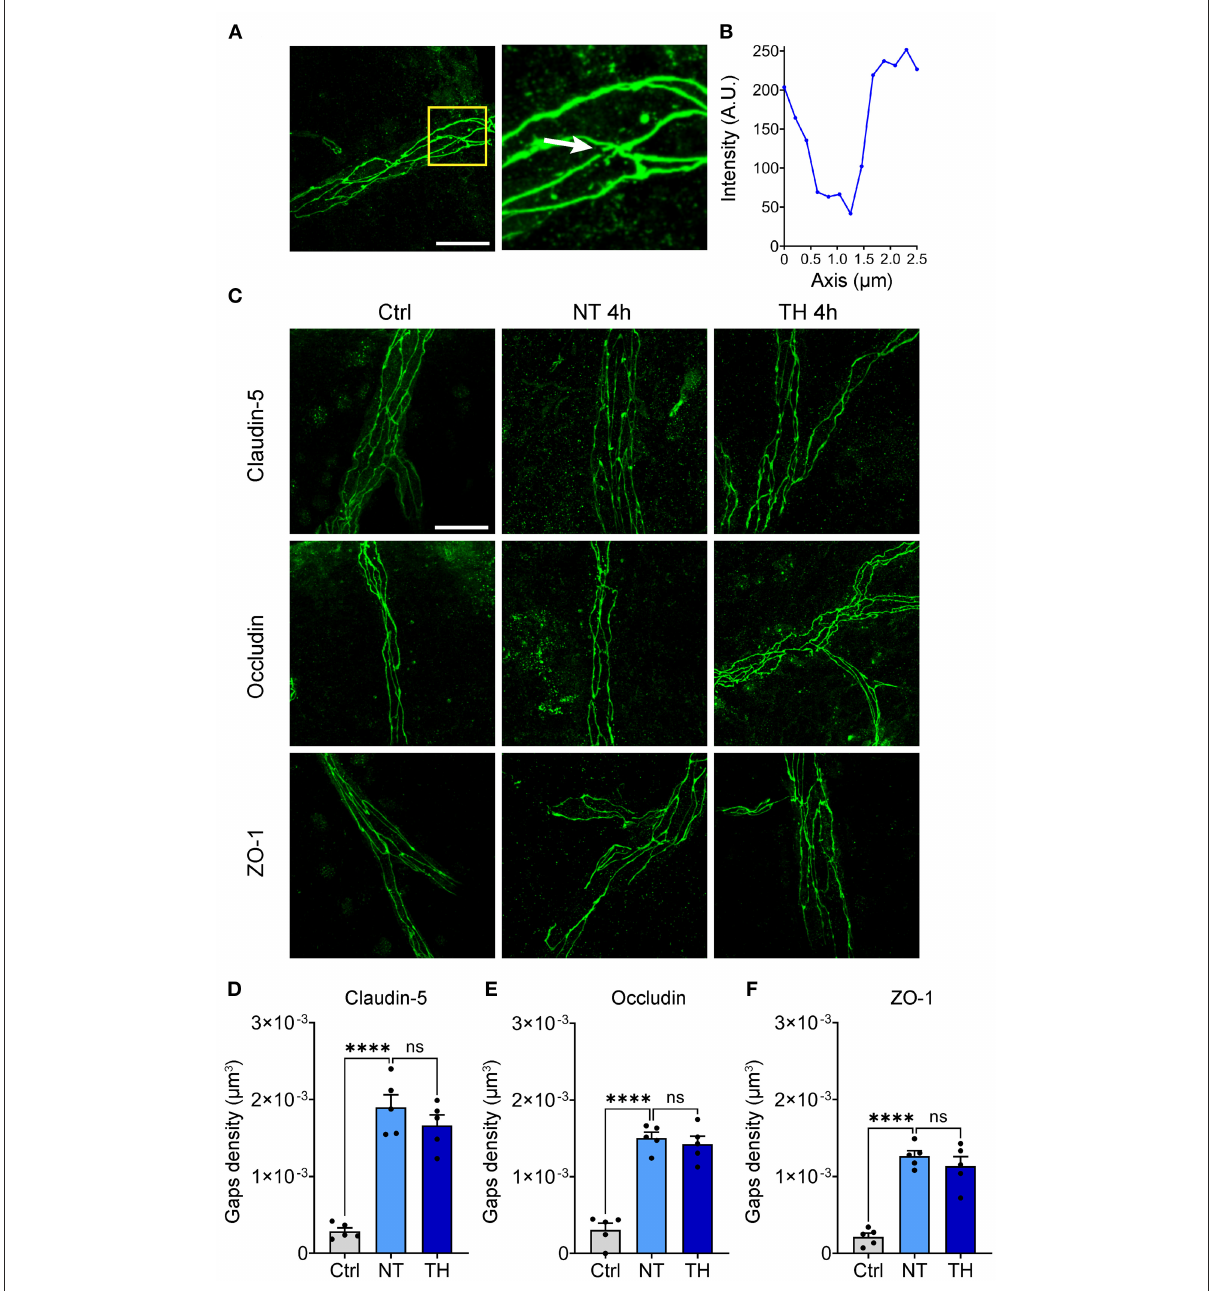
FIGURE4 The effect of TH on structural damage to the TJs after SCI. (A) Representative images of the gaps in the TJs (white arrow). Scale bar: 20 µ m. (B) Fluorescence intensity decline of the gap in Figure 1A. Fluorescence intensity declines of 70% were identified as a gap. (C) Representative images of immunofluorescence staining of TJs 4h post-SCI. Scale bar: 20 µ m. (D) The density of the gaps that emerged on claudin-5 with TH 4h post-SCI ( n = 5 per group, total 153 vessels, Ctrl & NT: P < 0.0001, NT & TH: P = 0.415). (E) The density of gaps that emerged on occludin with TH 4h post-SCI ( n = 5 per group, total 152 vessels, Ctrl & NT: P < 0.0001, NT & TH: P > 0.99). (F) The density of gaps that emerged on ZO-1 with TH 4h post-SCI ( n = 5 mice per group, total 157 vessels, Ctrl & NT: P < 0.0001, NT & TH: P = 0.609). Data are shown as mean ± SEM; ns, non-significance; **** P < 0.0001; nested, one-way ANOVA with Bonferroni’s post hoc test.